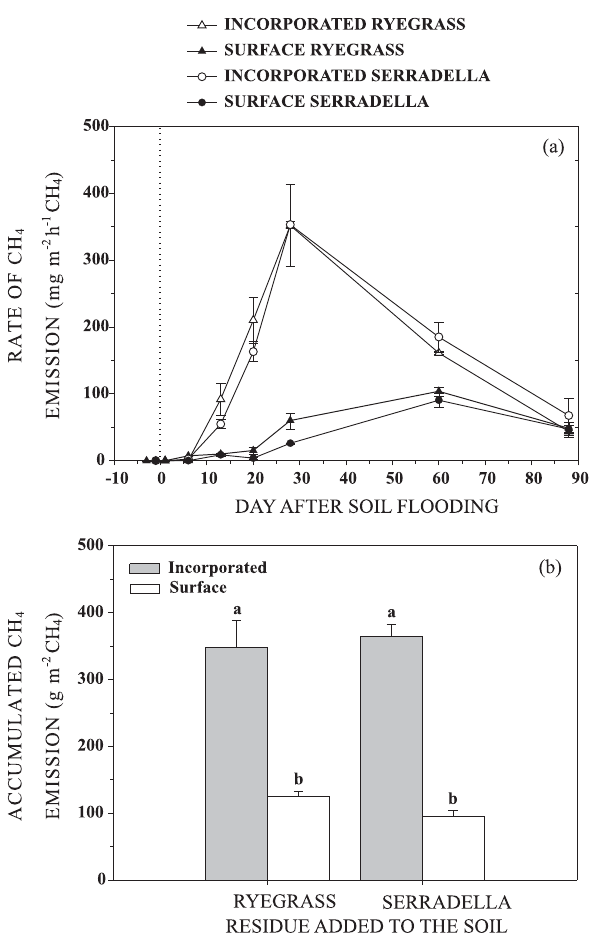
Figure 2. Emission rates (a) and accumulated emission (b) of CH from a flooded Albaqualf 4 cultivated with rice as affected by management (incorporation or maintenance on soil on the soil surface) of ryegrass and serradella residues. Vertical bars indicate standard deviation. Different letters on bars indicate statistical difference by Tukey’s test at 5